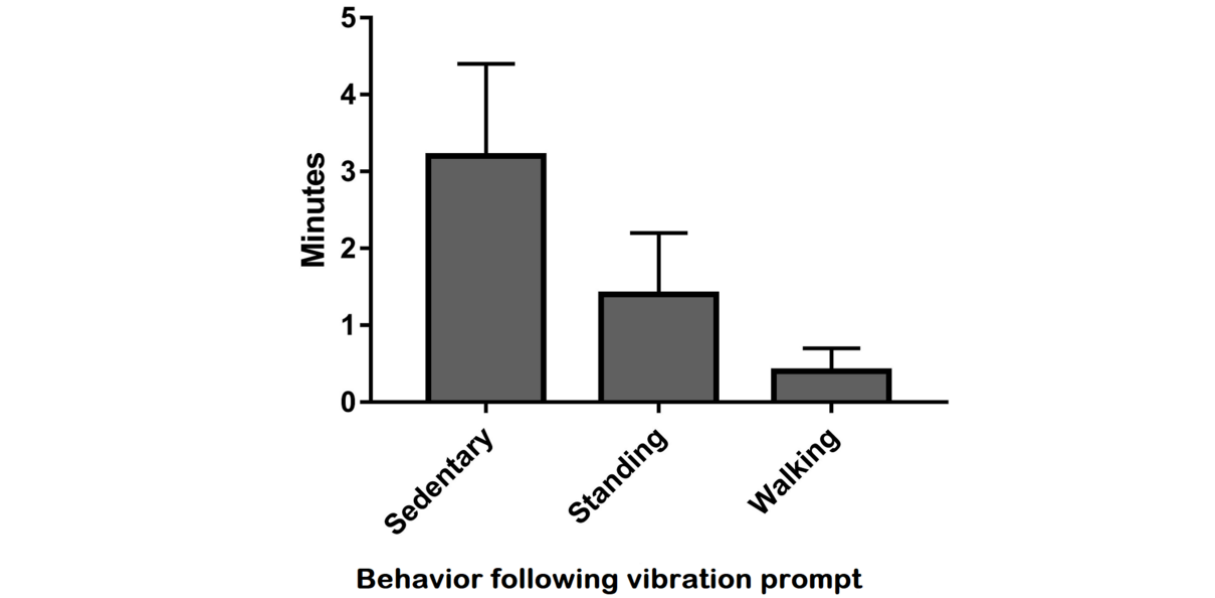
Figure 3. Behavioral responses to the vibration prompt for the 5 min following the prompt